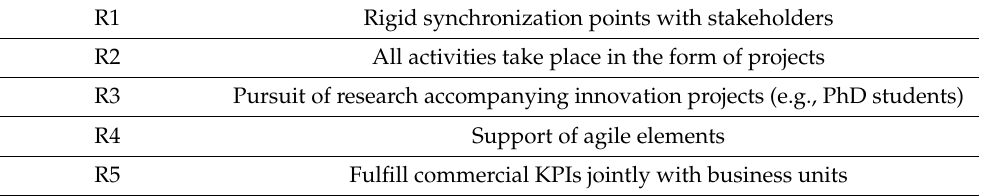
Table 1. Main Requirements for the Integrated Method. R1 Rigid synchronization points with stakeholders R2 All activities take place in the form of projects